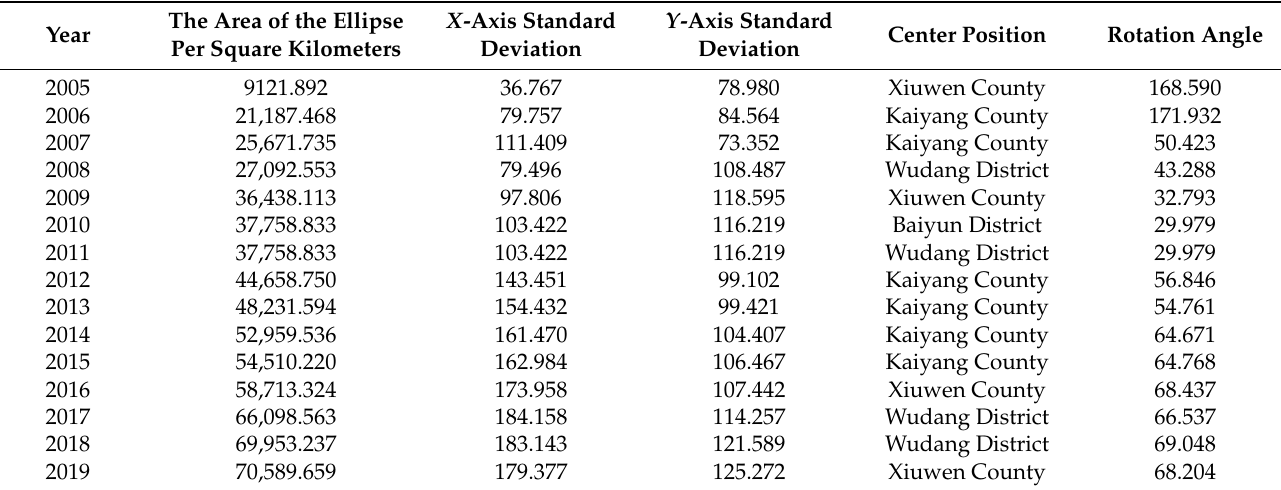
Figure 7. Standard deviation ellipse of the spatial distribution of A-level scenic spots in Guizhou Province. Table 3. Calculation results of the standard deviation